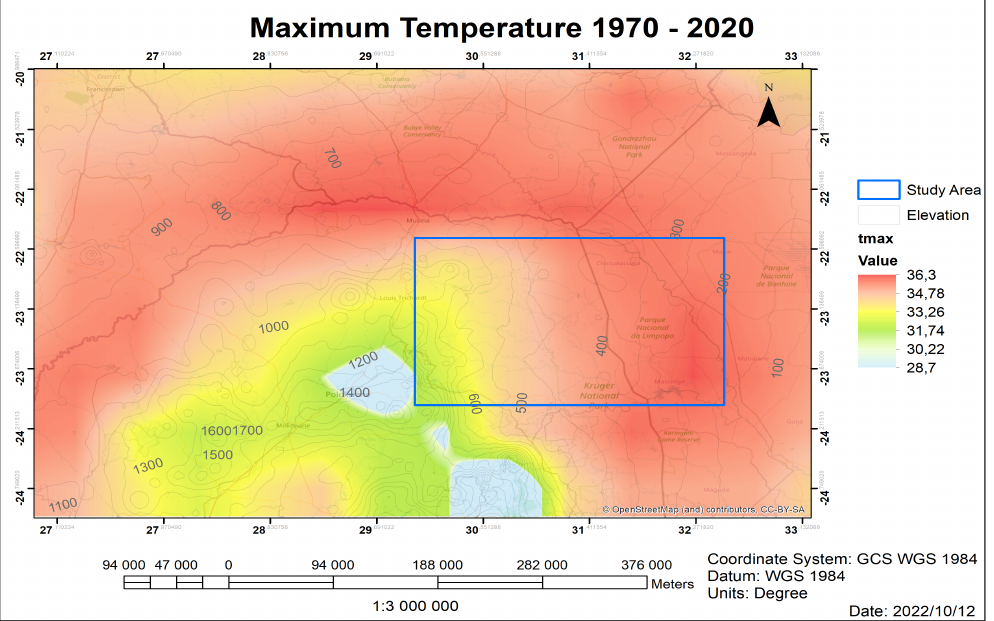
Figure 3. Map showing the annual maximum temperature of the study area in the Lowveld region of Limpopo. Source: Authors’